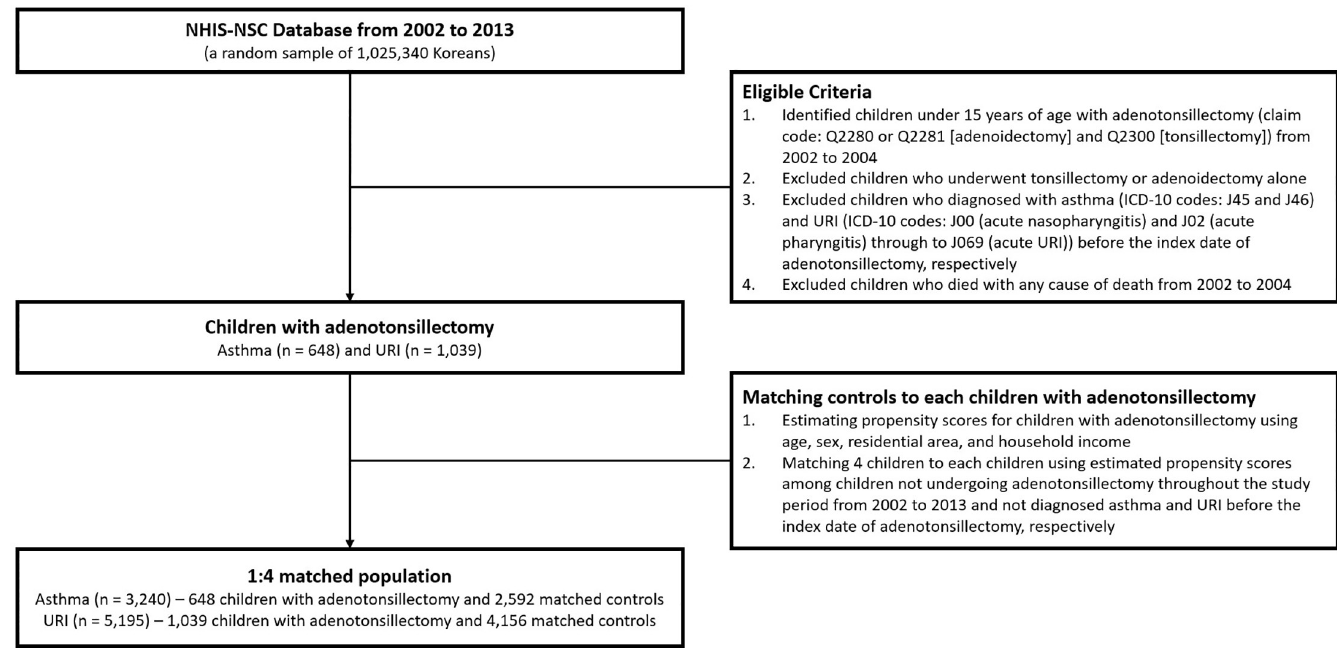
Fig 1. The diagram presents the eligibility criteria for children who underwent adenotonsillectomy and their matched